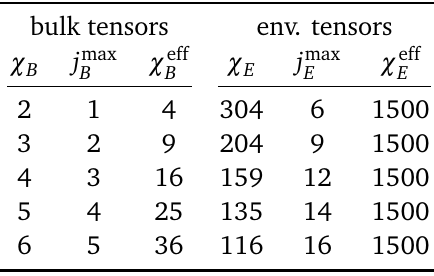
Table 1: Symmetric bond dimension ( χ ), maximal spin j max and effective bond di- mensions ( χ eff ) for the tensor indices of the bulk tensors of the partition function, and for the CTM environment indices at temperature T =